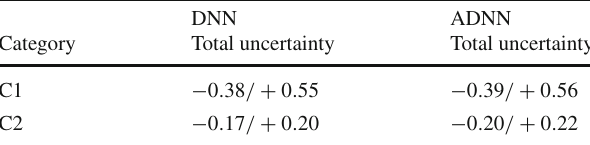
Table 4 Expected 68% CL uncertainties (statistical and systematic) in the signal strength parameters, evaluated on the Asimov data set corresponding to the SM hypothesis and employing the VBF-output of both the ADNN and the DNN as a fit variable